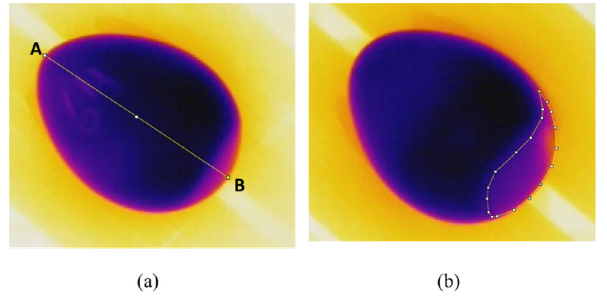
Figure 4. ( a ) The calibration process was performed by scaling the known distance from point “A” to point “B”. ( b ) The area was determined by calculating the number of pixels under the delimited contour in relation to the known distance defined in ( a ). contour in relation to the known distance defined in ( a